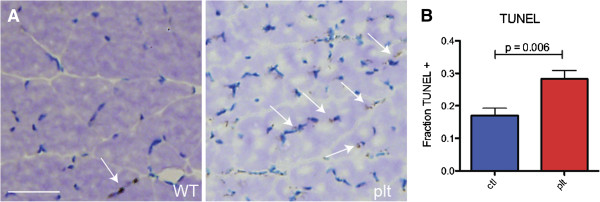
Increased apoptosis in plt skeletal muscle and skeletal myocytes. (A) Terminal deoxynucleotidyl transferase-mediated dUTP nick end labeling (TUNEL) staining was performed on sections from wild-type (WT) and plt skeletal muscle. Arrows point to TUNEL-positive nuclei. There was a qualitative increase in TUNEL-positive fibers in plt muscle (experiment repeated with sections from three different mice per condition). (B) TUNEL staining was performed on myocytes. There was a significant increase in TUNEL-positive cells in plt myocytes vs WT myocytes. Data reflect fraction of 4′,6-diamidino-2-phenylindole-positive nuclei that were also TUNEL-positive. Numbers were 0.28 ± 0.06 for plt and 0.17 ± 0.05 for WT (P = 0.006). One hundred cells per experiment were counted, and each experiment was repeated five times (once for each culture derived with cells isolated from five different mice per condition).